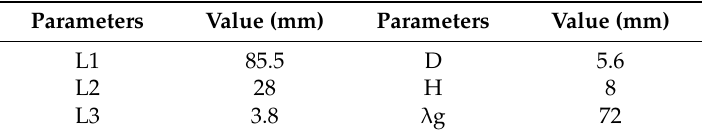
Table 1. Geometrical parameters.